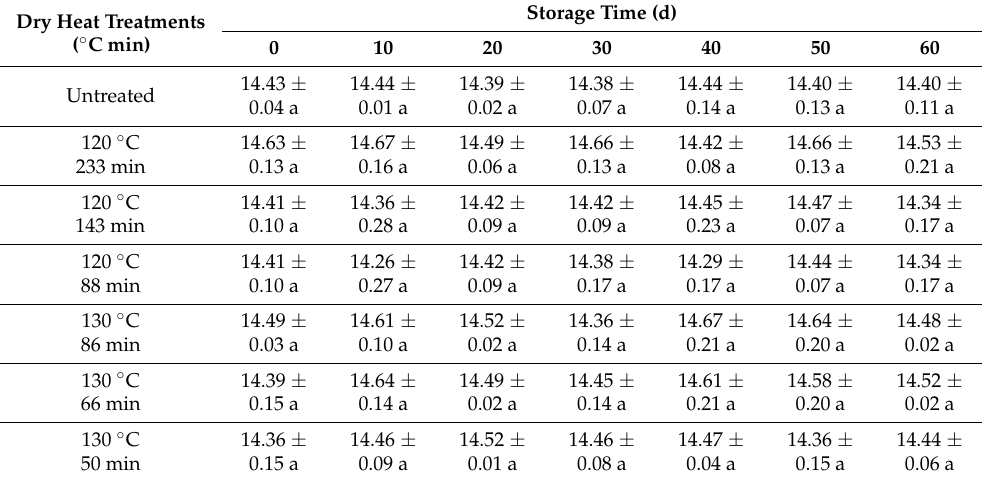
Table 2. Changes in crude protein content (%) in dry-heat-treated rice bran